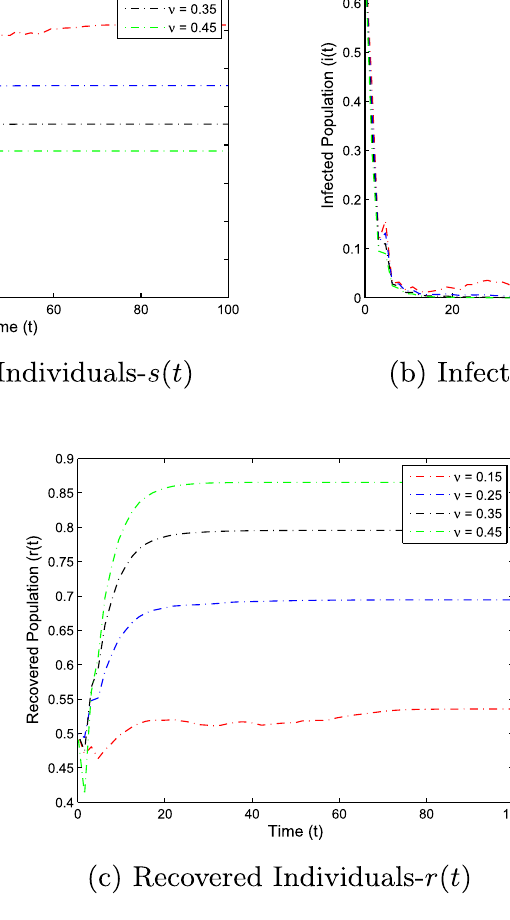
Figure 6. The graphs illustrate the effect of vaccination on the dynamics of susceptible, infected and recovered population in case of disease extinction. We noted that whenever the progress of vaccination are increases, the susceptible and infected population are decreases while the recovered population are